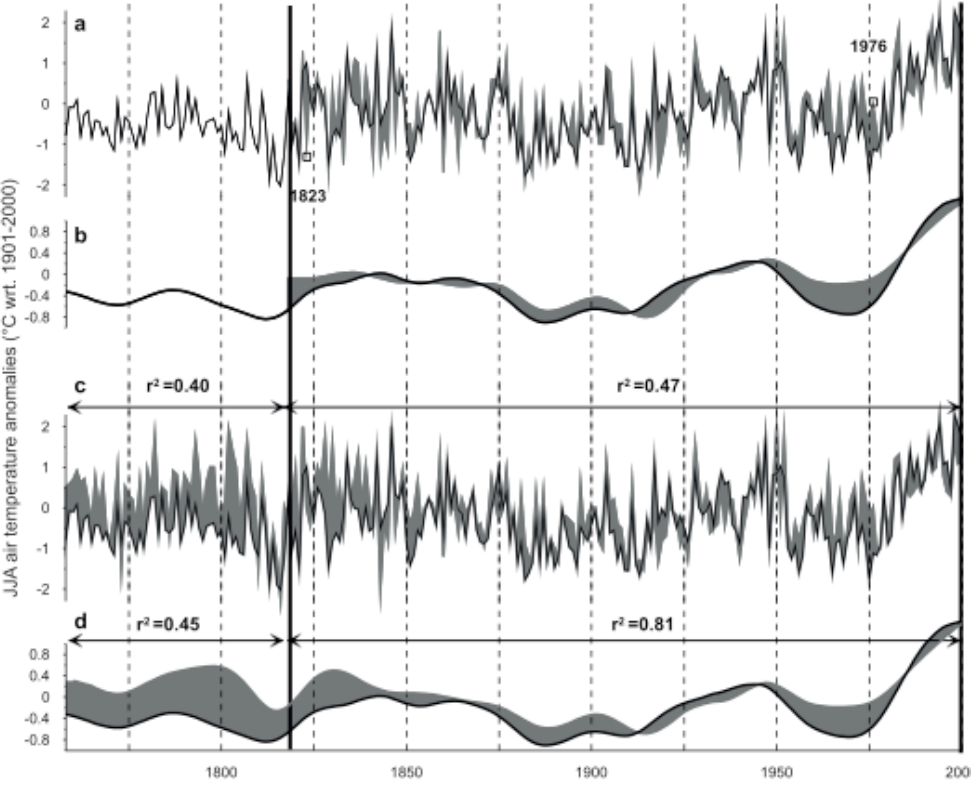
Fig. 4. Comparison of the bootstrap ANN reconstruction of the JJA temperatures against the high-elevation ( a , grey) JJA mean temperatures (1818–2000) and extra verification using low-elevation data ( c , grey) back to 1760. (b), (d) : the 20-year low-pass filter of the bootstrap ANN reconstruction (black) and JJA mean temperatures at high and low elevations (grey). Temperatures are expressed as anomalies with regard to 1901–2000. Grey shadings denote the offset between (warmer) early instrumental and (colder) proxy data.